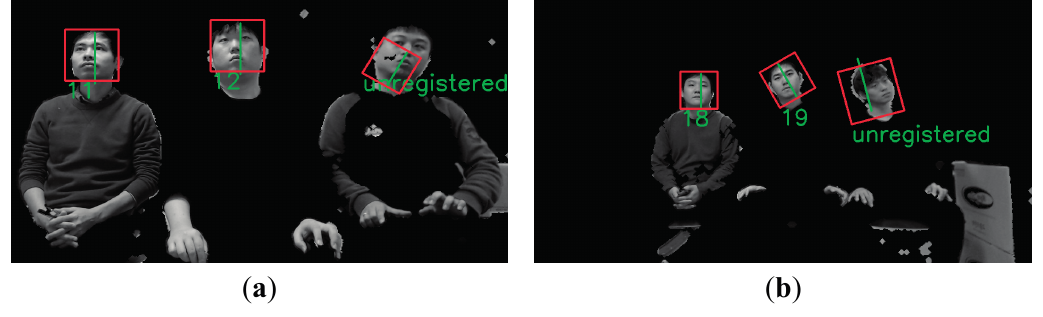
Figure 16. Examples of face recognition failures ( a ) Face recognition failed because of inaccurate preprocessing of Figure 2a; ( b ) Face recognition failed because of the incorrect detection of axis of face symmetry based on GLDH.